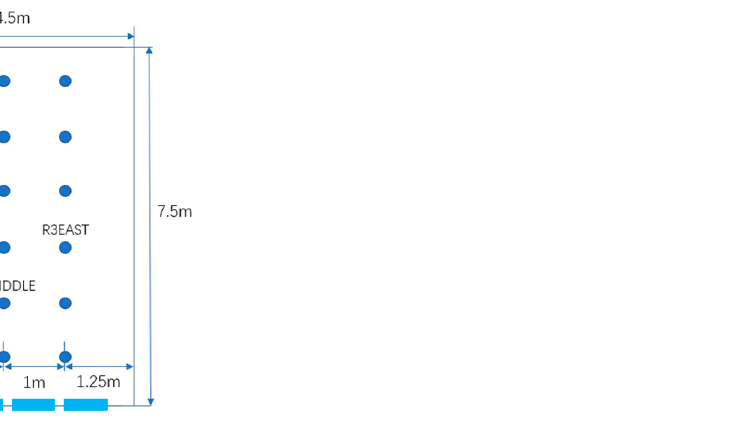
Figure 1. Distribution diagram of alternative sensor locations in the open-plan office space.